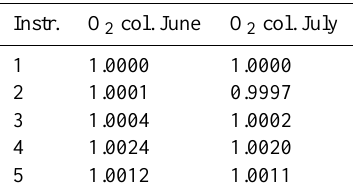
Table 2. Calibration factors for O 2 column for the different instru- ments. Measurements were performed in June and July 2014, in between the spectrometers were transported for campaign measure- ments. Instrument 1 has been scaled to one, which is an arbitrary choice. Instr.